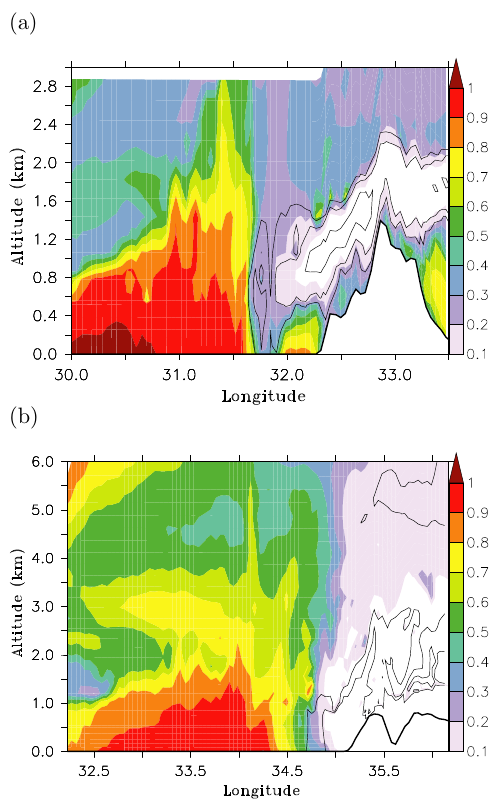
Fig. 5. Coarse mode (aerosol bins 5–8) bulk hygroscopicity at 34.9 ◦ N, 20:00UTC, 25 September 2008 (a) and at 33.3 ◦ N, 2:00UTC, 29 January 2003 (b) for scenario τ 1 . Contour lines show dust concentrations (50, 100 and 500 µgm − 3 ). The thick black line marks the